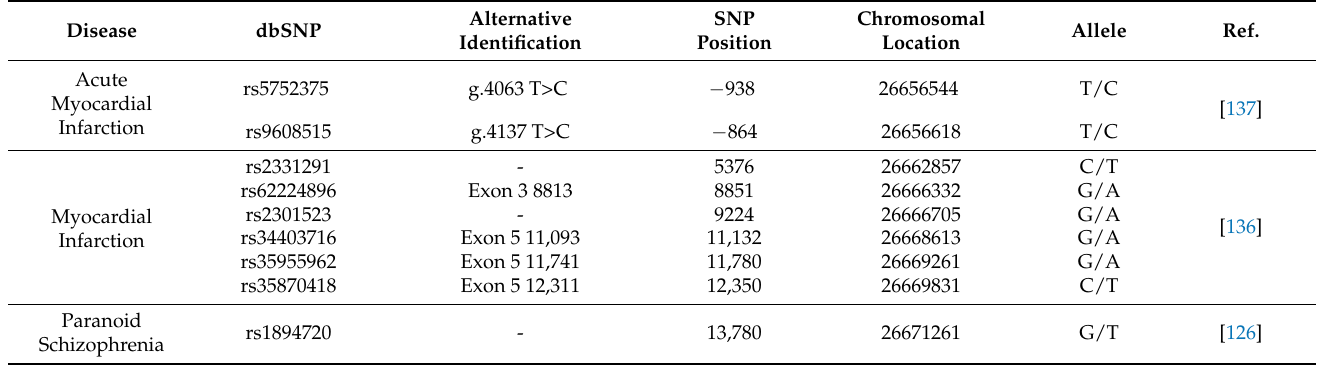
Table 1. Acute myocardial infarction, myocardial infarction, and paranoid schizophrenia SNPs significantly associated with the lncRNA GOMAFU and their chromosomal